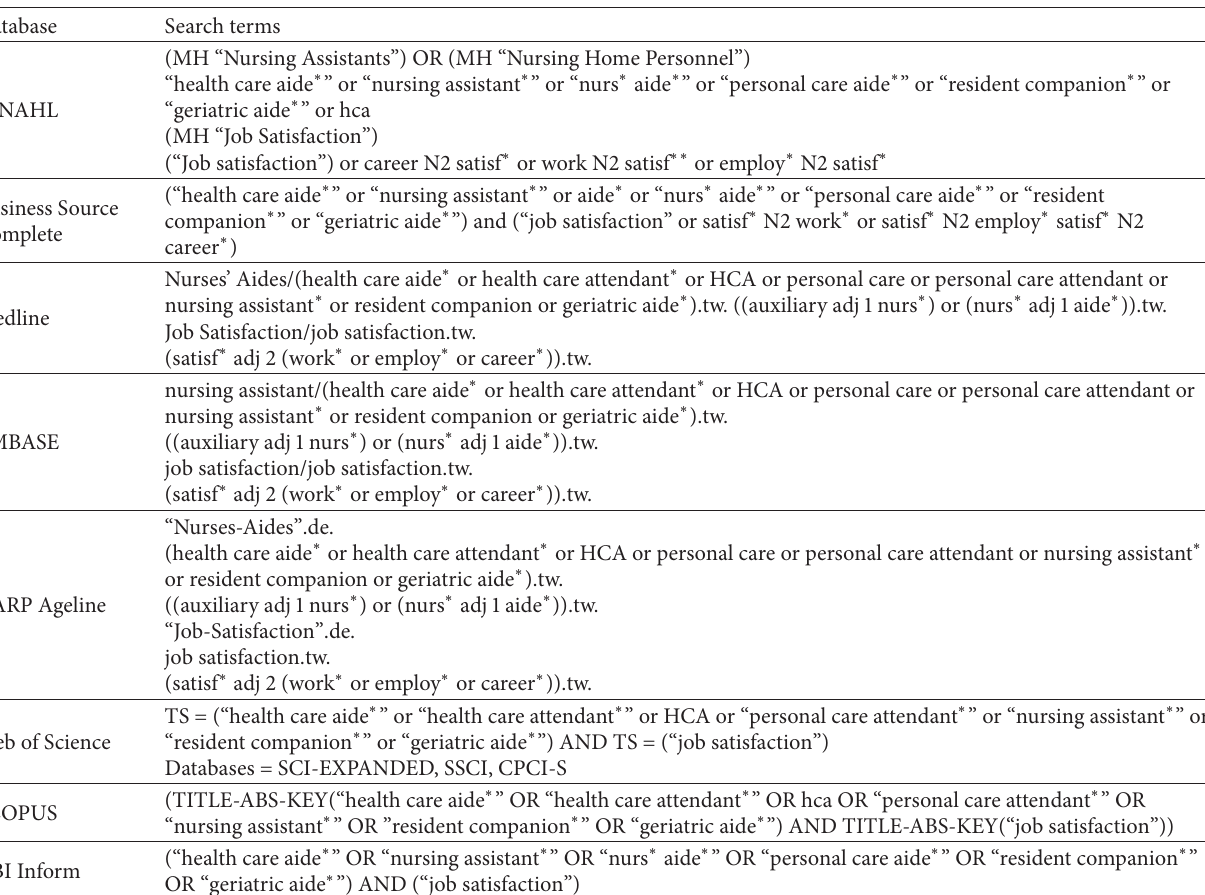
Table 1: Search strategy (all searches performed through to May 1,